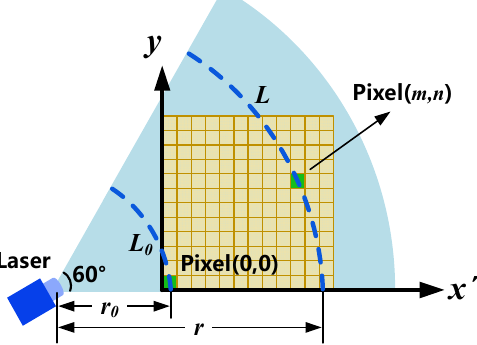
Figure 2. Schematic of laser detection plane.